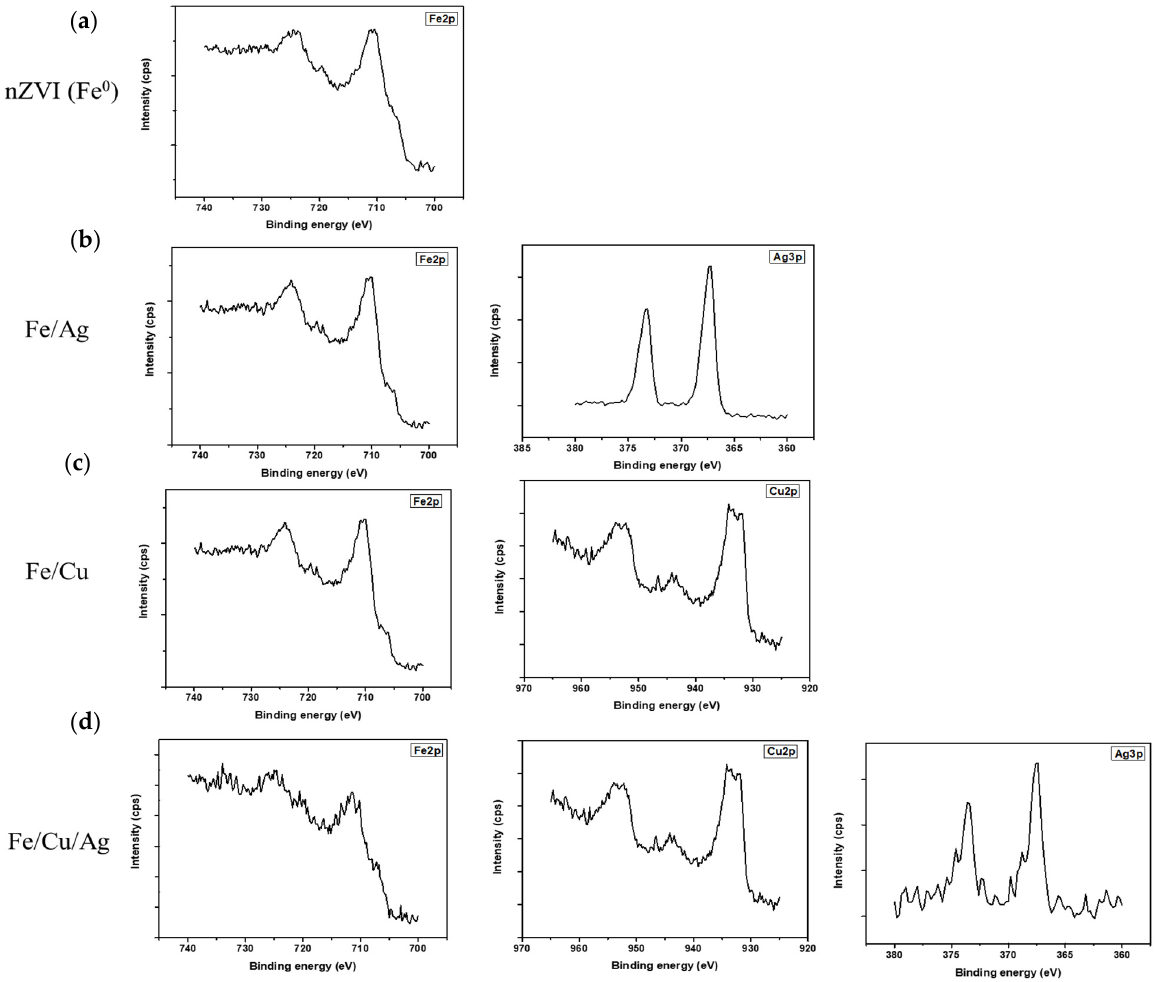
Figure A1. XPS narrow scan spectra of the nanoparticles: ( a ) Fe 0 /nZVI-Fe2p, ( b ) Fe/Ag (5:0.1)-Fe2p and Ag3d, ( c ) Fe/Cu (5:1)-Fe2p and Cu2p and ( d ) Fe/Cu/Ag (5:1:0.2)-Fe2p, Cu2p and Ag3d.